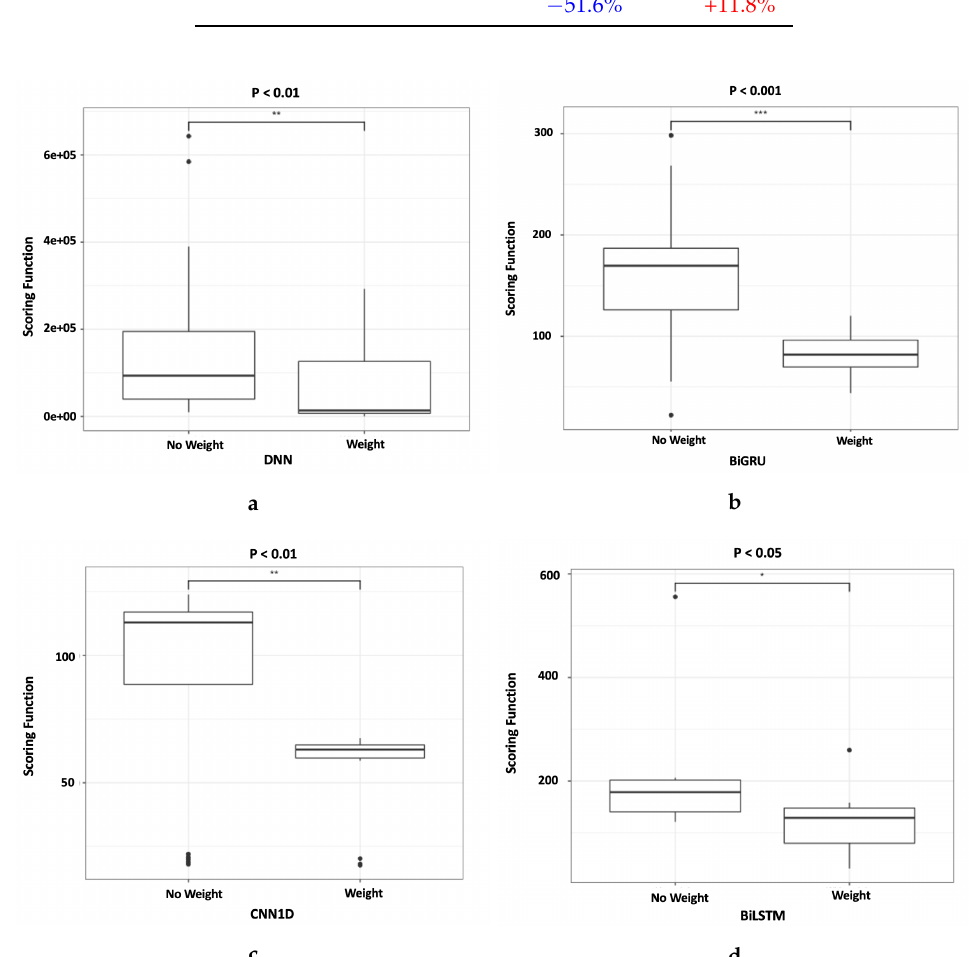
Figure 12. Boxplots of all scoring functions result from the four deep learning models, ( a ) DNN, ( b ) Bi-GRU, ( c ) CNN1D, and ( d ) Bi-LSTM using a dynamically weighted loss function, and without the weight. The asterisk on the top of each boxplot denotes the p -value where “***” < 0.001, “**” < 0.01, “*” <